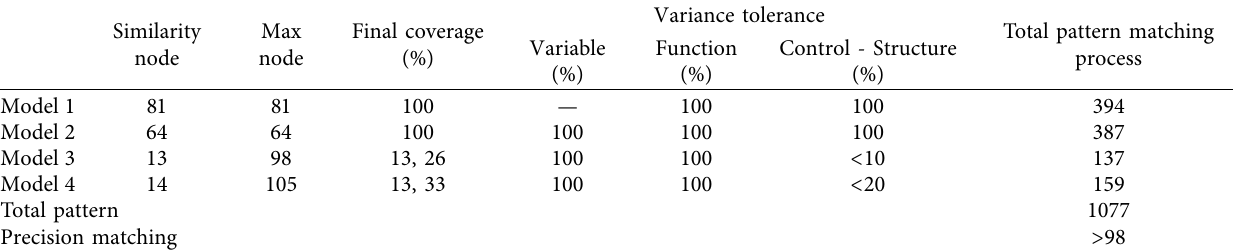
Table 11: Static grading precision result.